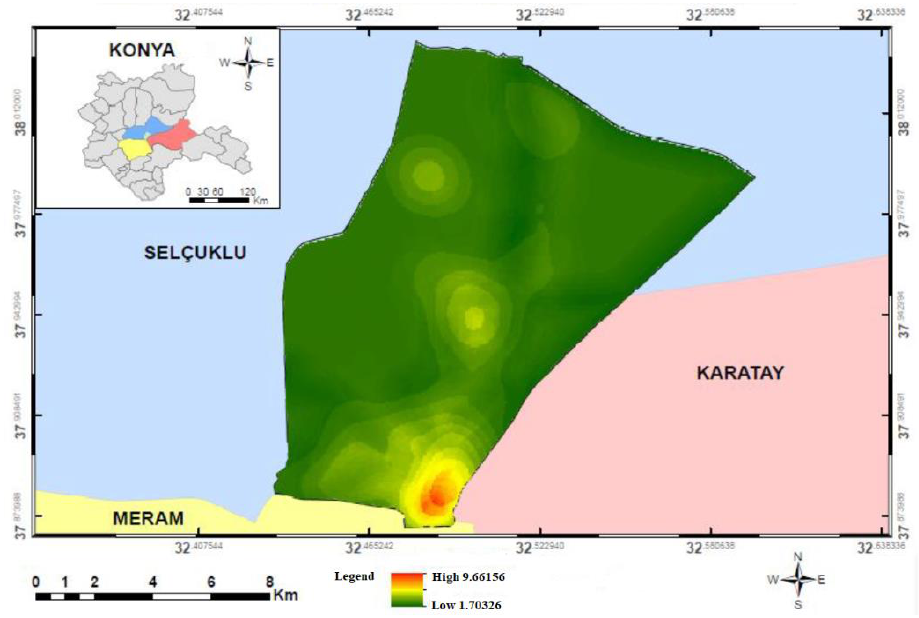
Figure 13. Suitable parking